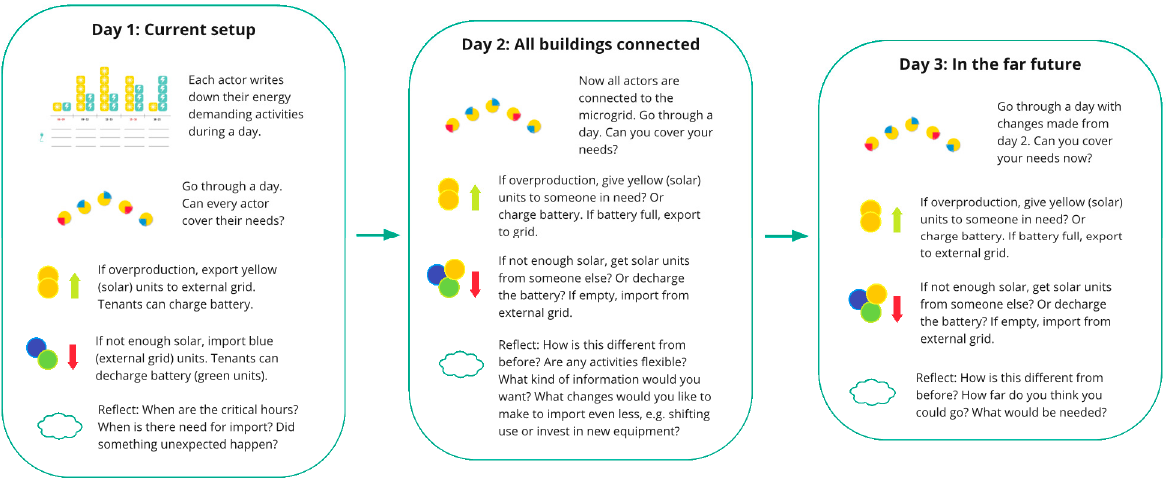
Figure 3. The setup of the microgrid board game.